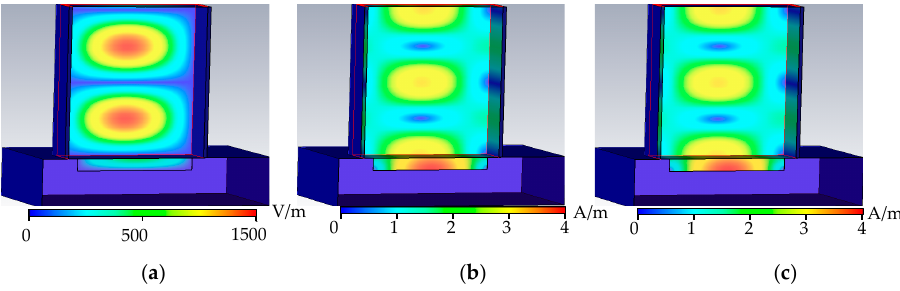
Figure 4. Crack defect field distribution. ( a ) Crack defect electric field distribution. ( b ) Crack defect magnetic field distribution. ( c ) Crack defect wall current distribution.